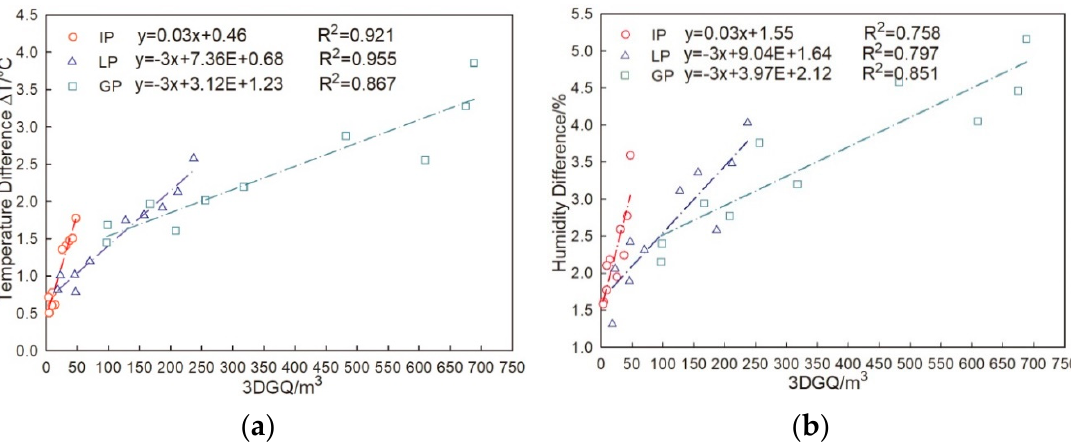
Figure 8. Correlation and fitting function model of 3DGQ of urban trees with different configuration modes. ( a ) 3DGQ and cooling effect; ( b ) 3DGQ and humidifying effect. IP: individual planting; LP: linear planting; GP: group planting; 3DGQ: three dimensional green quantity.